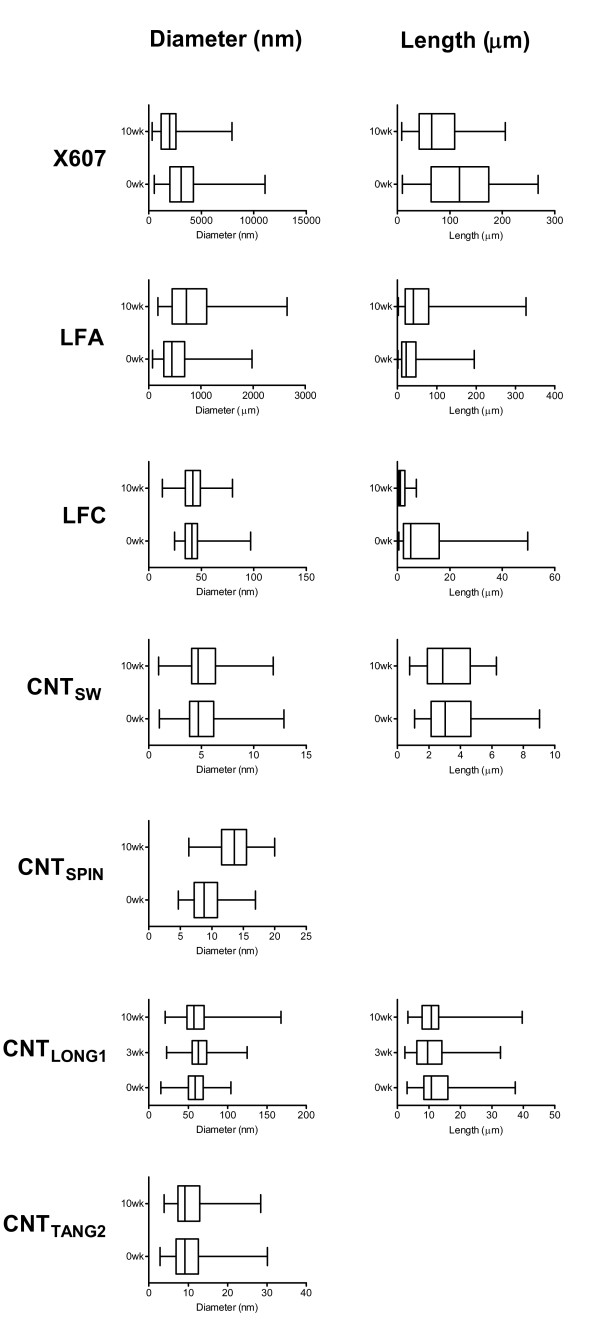
Effect of incubation in Gambles solution on fibre widths and lengths. Boxplots showing the distribution of fibre widths and lengths (nm) in samples that had been incubated in Gambles solution for 0 weeks or 10 weeks. The line in the box represents the median value of measurements from TEM images, and the edges of the box represent the lower and upper quartiles. The ends of the whiskers represent minimum and maximum values.